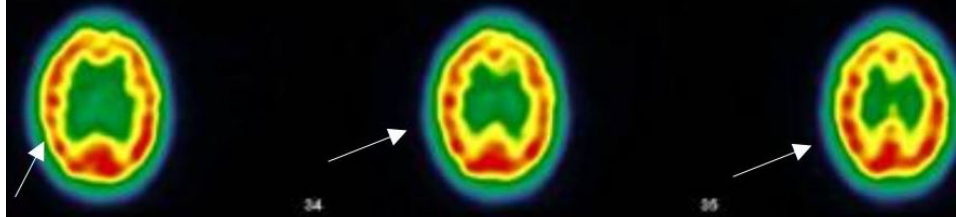
Figure 3. Case MGA010, F, 46, May 2021 ; SPECT-CT examination (ECD Tc-99m): The image shows three brain sections of the same patient.The arrows show the defects of perfusion. The red areas indicate a good tracer fixation and thus a good perfusion. The decrease in flux intensity is highlighted by the color change from red to yellow (see arrows). This indicate hypofixation and thus ischemia. Protocol ; “ Heterogeneous tracer fixation with clearer left frontal, left parietal and right parietal hypofixations. No preservation of the sensory-motor cortices. The fixation in front of the grey nuclei and the cerebellum is correct. Presence of periventricular hypocaptation. Conclusion: Evidence of heterogeneous tracer fixation and periventricular hypocaptation compatible with vascular-type cerebral damage. ” (Images and protocol: Drs Bouazza and Mahy, Vesalius Hospital, ISPPC, Belgium).